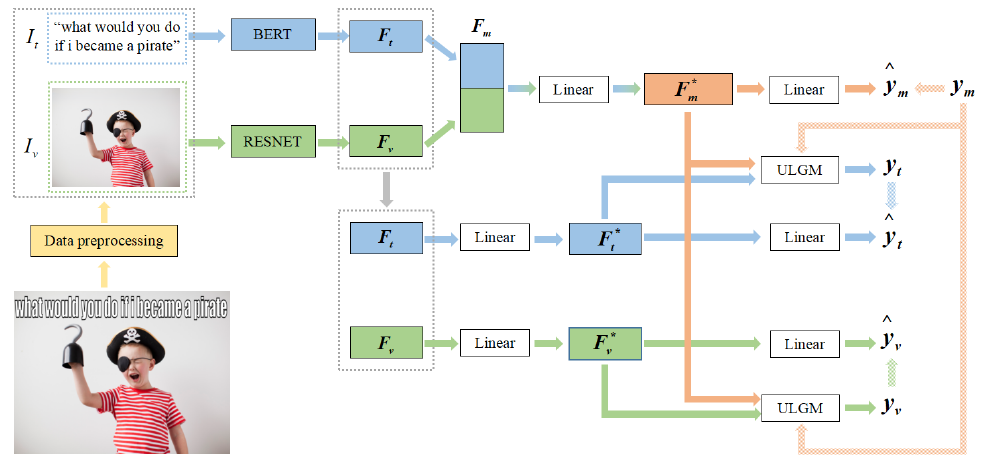
Figure 3. The architecture of our method. y m is the labeled multimodal label in the dataset, and y t , y v are the auxiliary labels generated by the self-supervised label generation module for the unimodal text and image auxiliary tasks, respectively. ˆ y m is the predicted output of the primary multimodal task, ˆ y t , ˆ y v are the predicted outputs of the unimodal text and image auxiliary tasks,